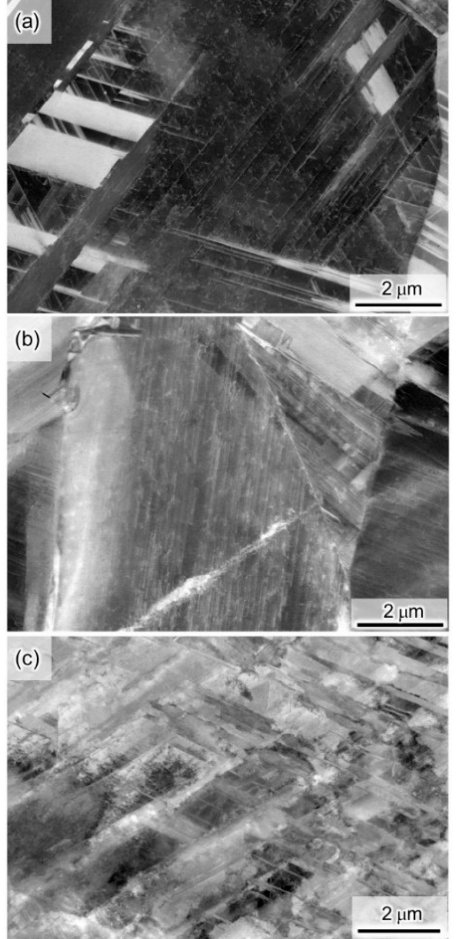
Figure 6. High-magnification ECCI images of ( a ) the as-solution-treated, ( b ) the low-temperature- annealed, and ( c ) the ausformed specimens.